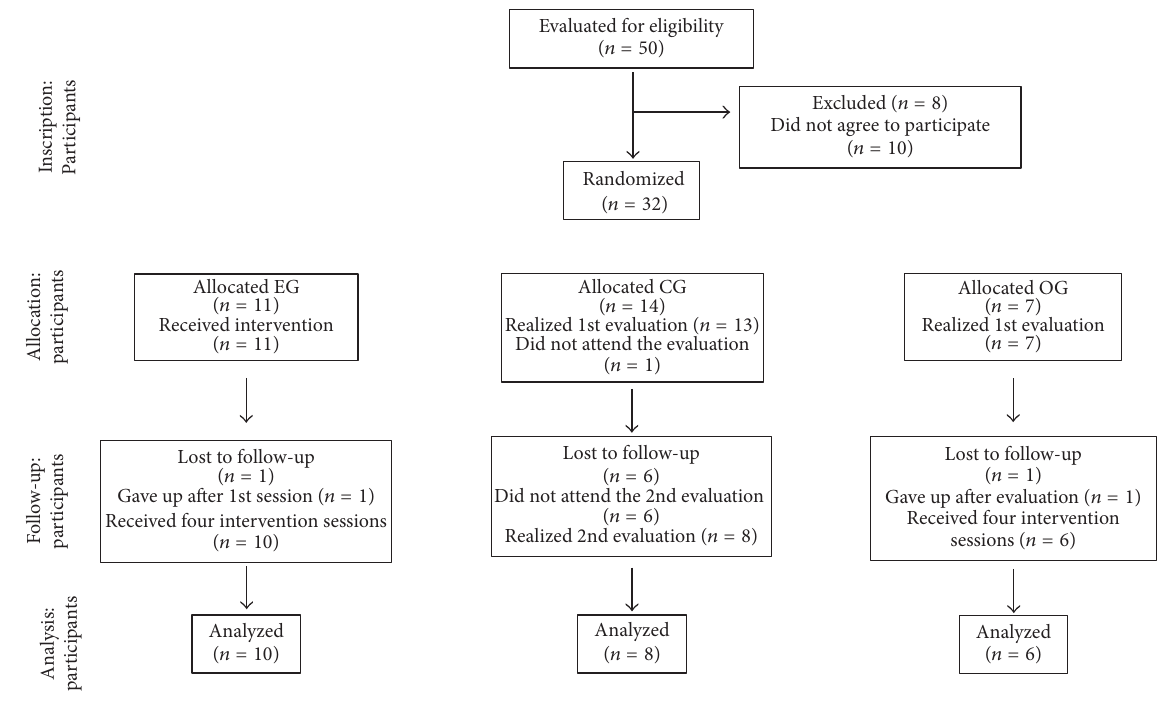
Figure 1: Steps of